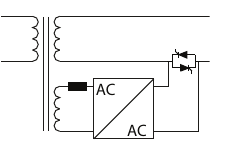
Figure 19. Hybrid transformer of configuration Figure 2e with bypass